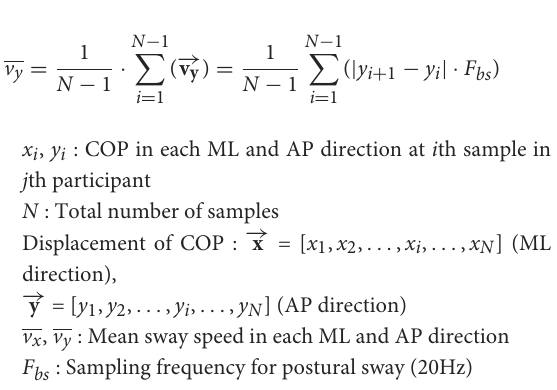
F bs : Sampling frequency for postural sway